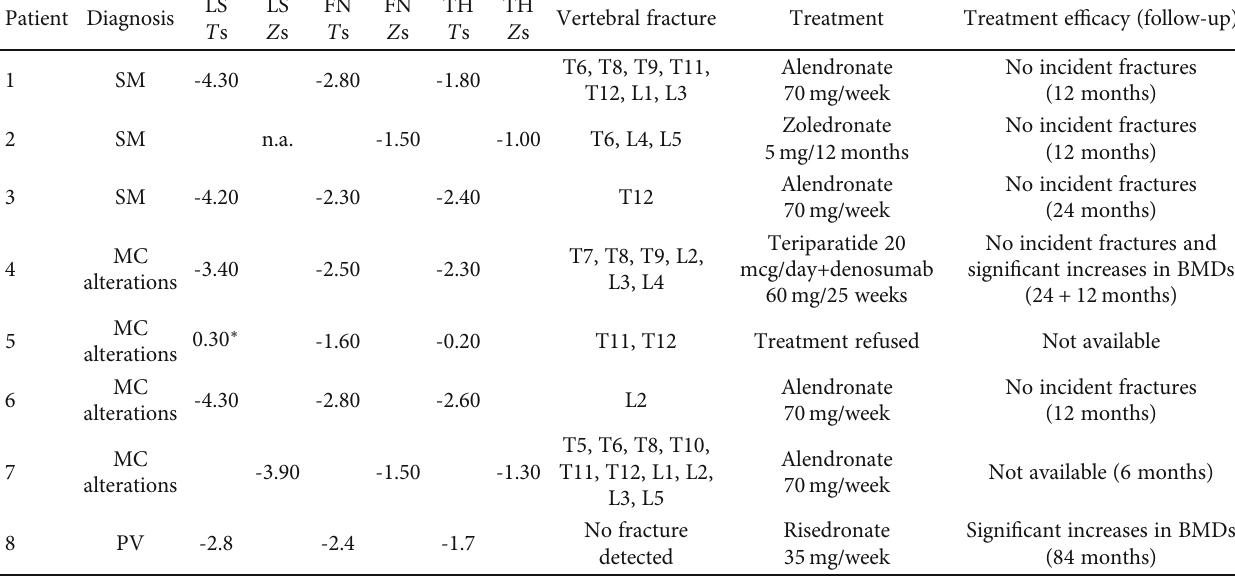
Table 3: Bone mineral densities and vertebral fractures in patients with SM and MC